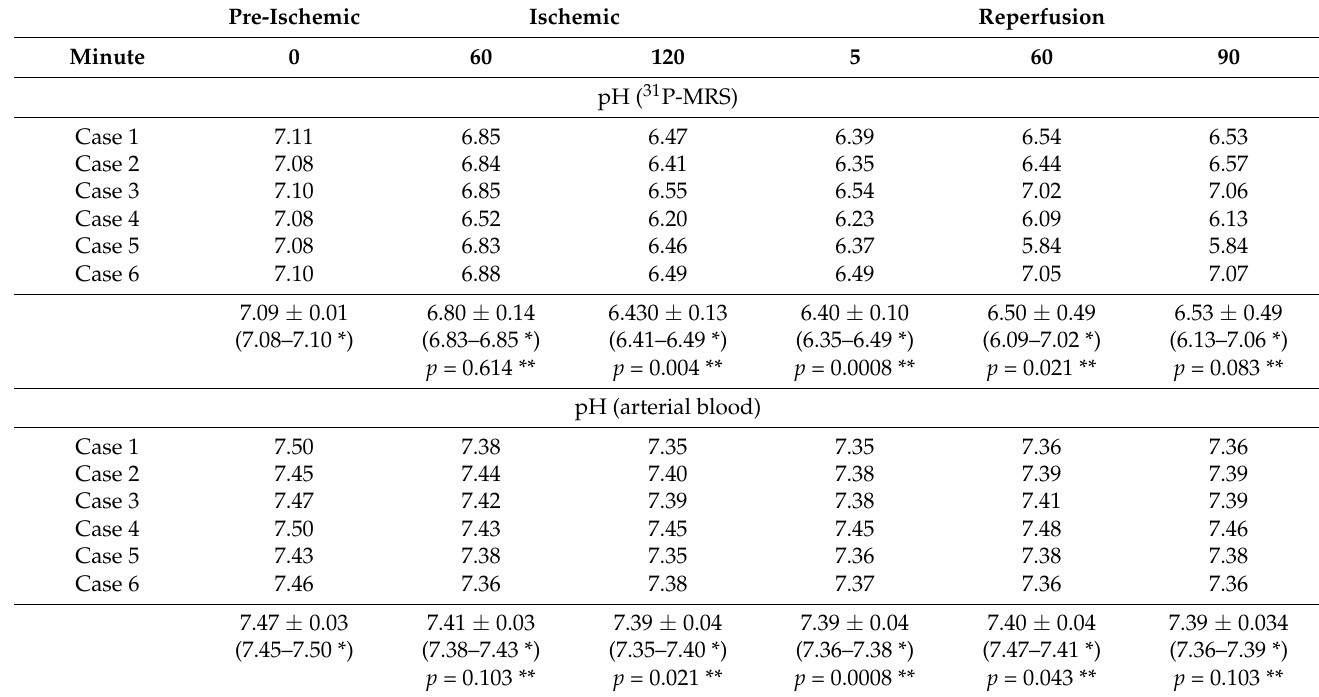
Table 2. Intracellular pH ( 31 P-MRS) and pH (arterial blood) at different time points. Pre-Ischemic Ischemic Reperfusion